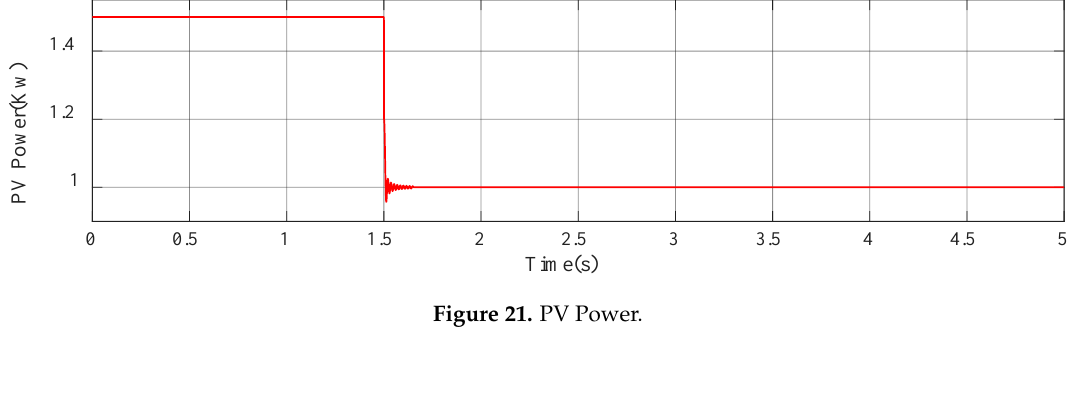
Figure 22. Battery Power. Figure 23. System voltage. The solar irradiation was dropped from 1000 W/m 2 to 800 W/m 2 at 𝑑𝑑 = 1.5 s and the PV system operates in this situation till 𝑑𝑑 = 5 s. In this period due to variation in solar irradiations, the PV system will produce less power than load demand. In this case, to satisfy the load requirements and preserve the desired bus voltage, the BESS will be discharged. The change of power and voltage limits are presented in Figures 21 – 23 for this case. It can be seen from these figures that during the variation of solar irradiation scenarios the system promptly regains the steady state values after a short transient. 4.6. Experimental Validations For further validation of proposed controller’s performance real-time hardware in loop (HIL) simulation tests were conducted. The controller HIL test setup is shown in Figure 24. Before practical implementation C-HIL experiments are economical method to examine the performance of controller. The equipment framework incorporates a host- PC, MCU F28379D Dual-Core C2000 Delfino Micro-controllers (Texas Instruments, Dallas, TX, USA) for the execution of control laws. C2000 Delfino support from the embedded coder was used to interface micro controller with MATLAB. C2000 Delfino